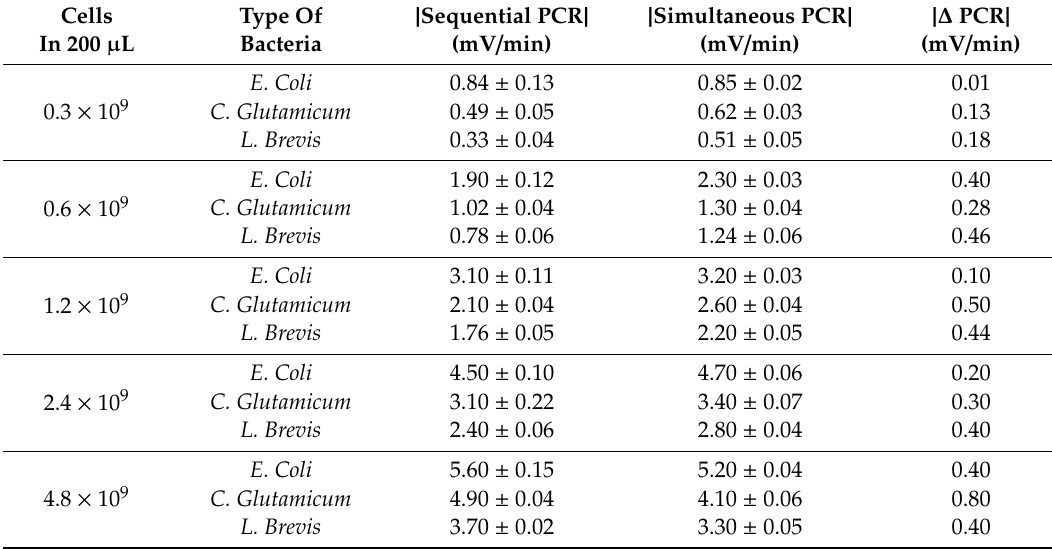
Table 1. Comparison of mean values and standard deviations of the potential change rate values obtained from sequential measurements (Figure 5) and simultaneous measurements (Figure 7) after adding cells for E. coli , C. glutamicum , and L. brevis . The glucose concentration of 1.67 mM was kept constant and the cell number was varied from 0.3 × 10 9 up to 4.8 × 10 9 cells. | ∆ PCR | describes the signal di ff erence between both